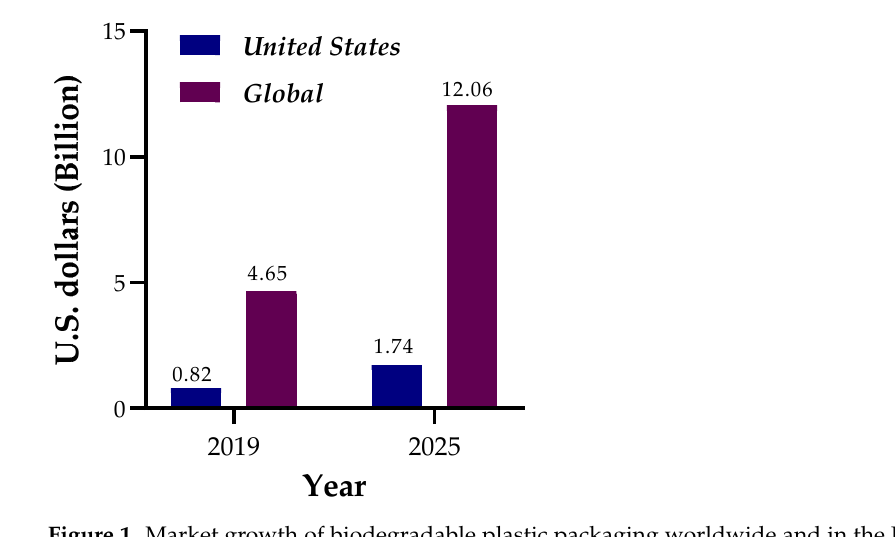
Figure 1. Market growth of biodegradable plastic packaging worldwide and in the United States. STATISTA analysis of the biodegradable plastic market value reports for 2021 [12,13] was used to collect the data.